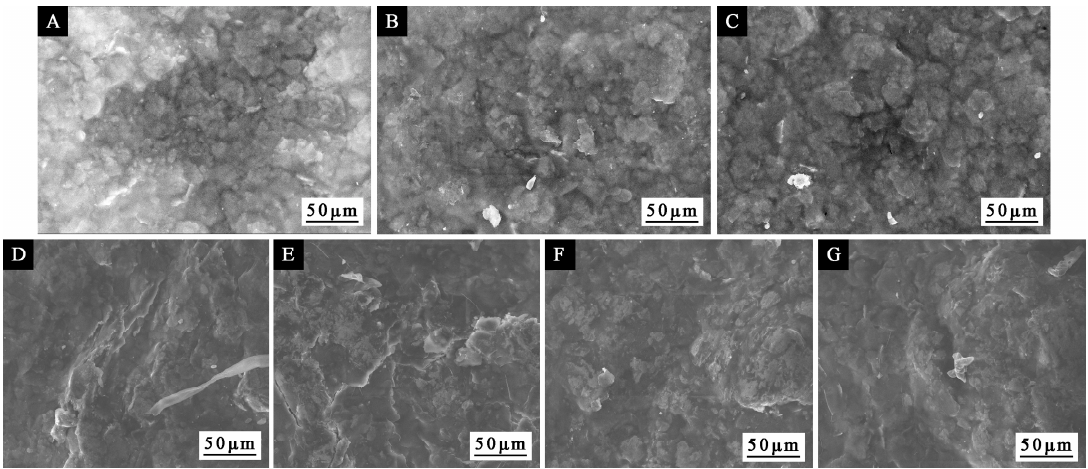
Figure 9. The electrochemical curve of the coating at drying time of 1.0 and 2.0 min.